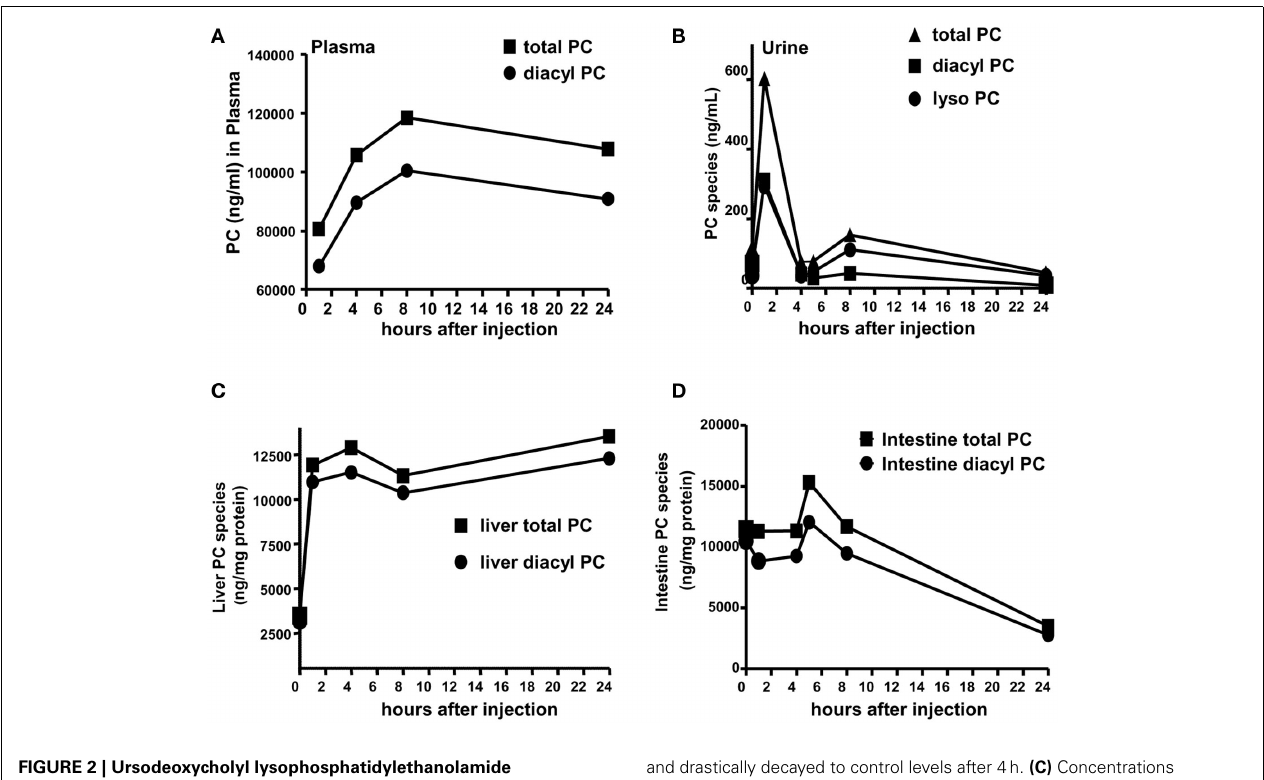
FIGURE 2 | Ursodeoxycholyl lysophosphatidylethanolamide increases PC levels in vivo . Mice were injected with 30mg/kg UDCA-LPE by an intraperitoneal injection. (A) Concentrations of PC species (total or diacyl PC) in ng/mL in plasma were increased after 2h and stayed elevated even after 24h. (B) Concentrations of total PC, diacyl PC, and lyso PC in ng/mL in urine were increased after 2h